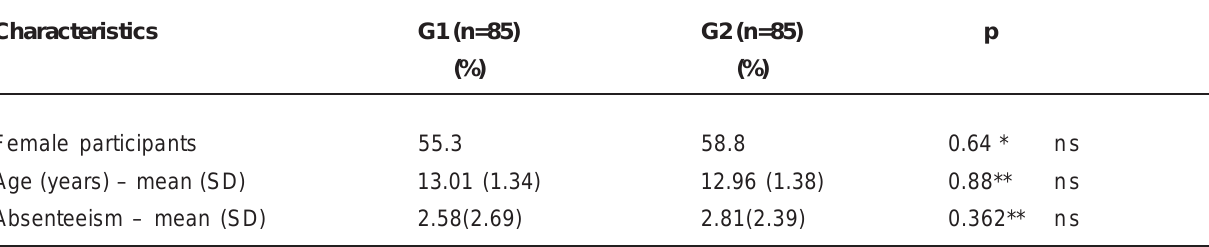
TABLE 1- Differential aspects of both groups at baseline